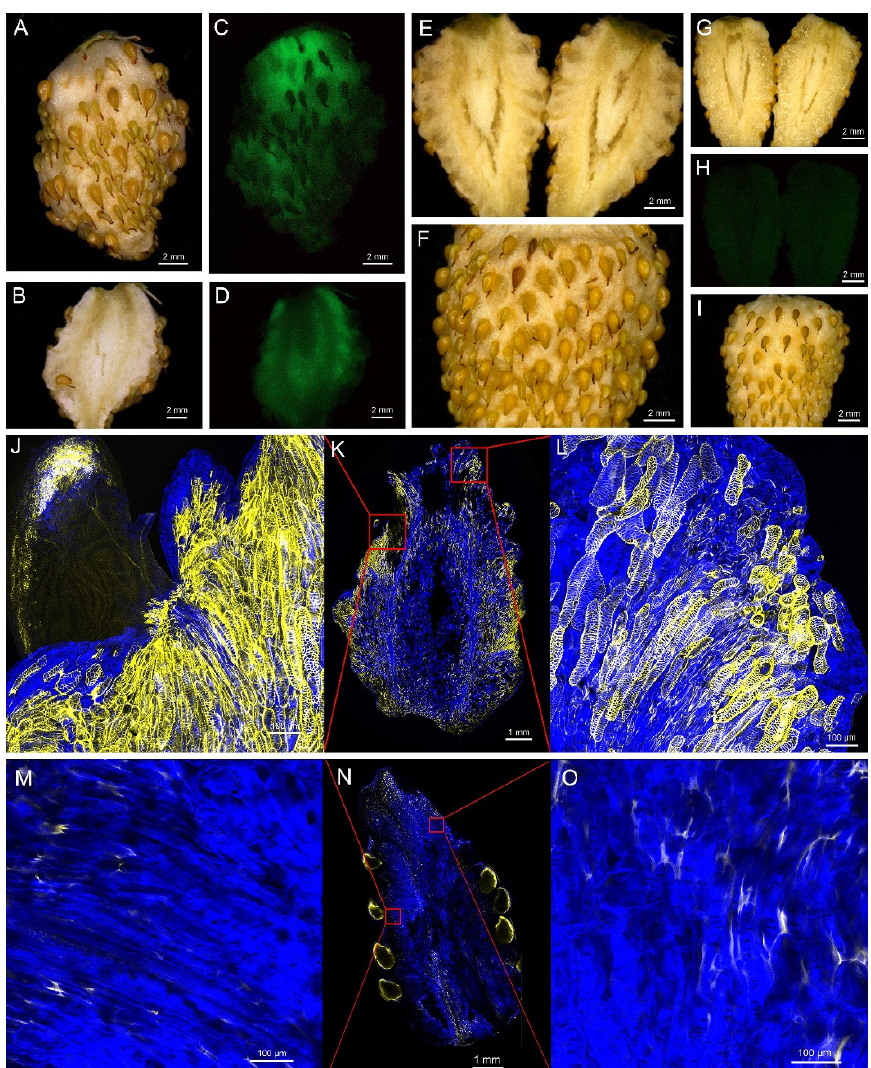
Figure 6. Overexpression of FvNST1b in strawberry fruits induced ectopic deposition of SCW. ( A , B ) A whole fruit ( A ) and a section image ( B ) of strawberry fruit at four days after Agrobacterium infection of 35S:FvNST1b-GFP . ( C , D ) GFP image of a whole strawberry fruit ( C ) and a section ( D ) of a strawberry fruit at four days after Agrobacterium infection of 35S:FvNST1b-GFP . GFP signal is detected in most part of fruit sample. ( E ) Section image of strawberry fruit at five days after Agrobacterium infection of 35S:FvNST1b-GFP . ( F ) Close-up view of strawberry fruit at five days after Agrobacterium infection of 35S:FvNST1b-GFP . ( G ) Section image of strawberry fruit at five days after Agrobacterium infection of empty vector. ( H ) GFP image of strawberry fruit at five days after Agrobacterium infection of empty vector without detectable GFP signal. ( I ) Fruit image at five days after Agrobacterium infection of empty vector. ( J – L ) Images of hand-sectioned 35S:FvNST1b infected fruit stained with Calcofluor White and Auramine O. Ectopic lignified secondary wall thickening is apparent as yellow signal in fruit cells. ( J , L ) is a magnified image of ( K ), with positions indicated as squares. ( M – O ) Images of hand-sectioned empty vector infected fruit stained with Calcofluor White and Auramine O. ( M , O ) is a magnified image of ( N ) with positions indicated as squares. Scale bars represent 2 mm for ( A – I ), 100 μ m for ( J , L , M , O ), and 1 mm for ( K , N ).